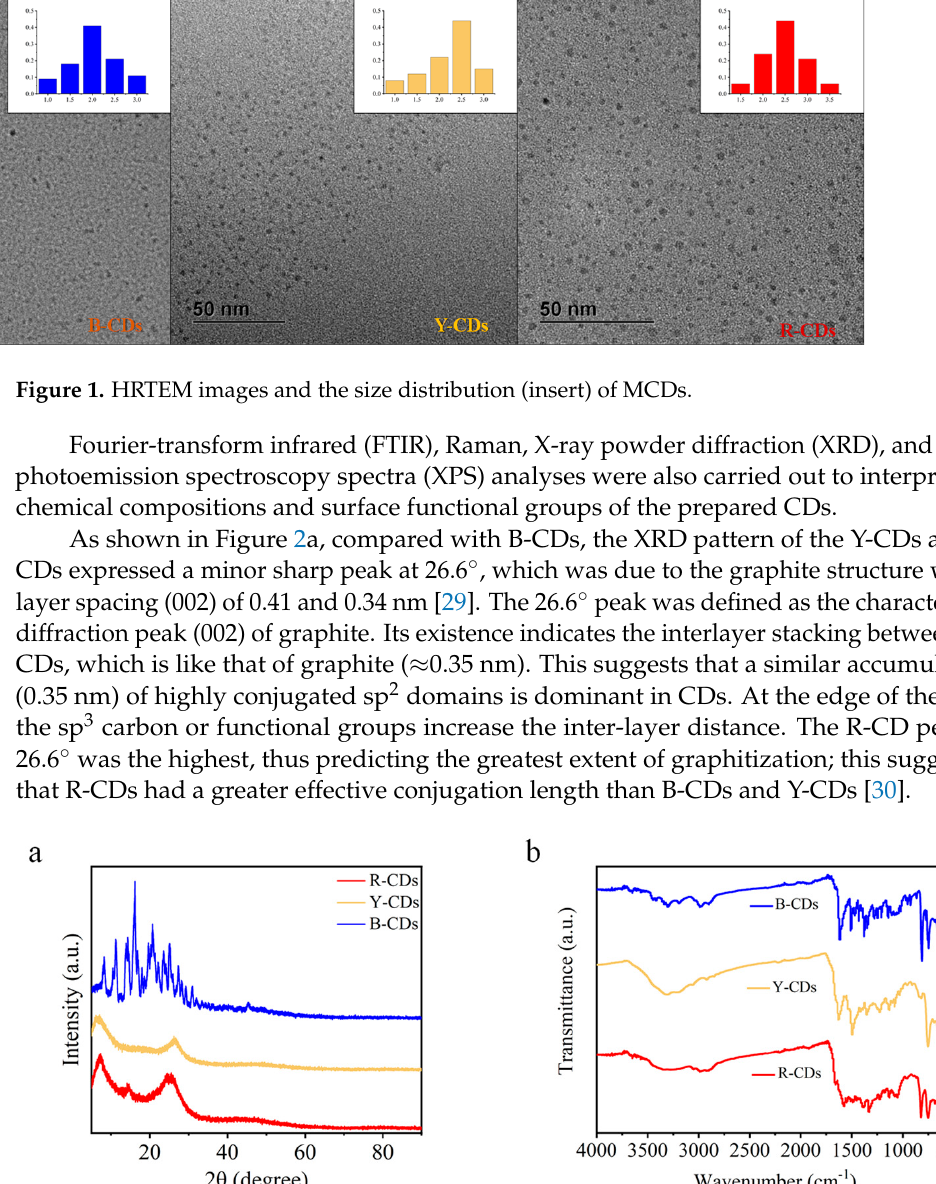
Figure 1. HRTEM images and the size distribution (insert) of MCDs.